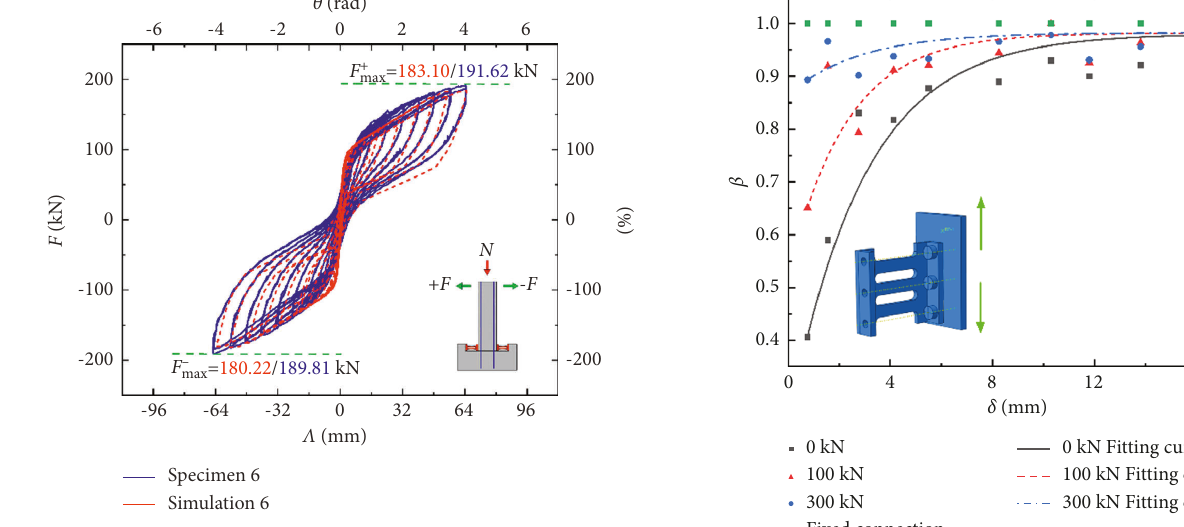
Figure 23: The comparison for hysteresis curves of FEA simulation and experiment. Table 8: The design of bolted connection RED working cases. Cases Bolt